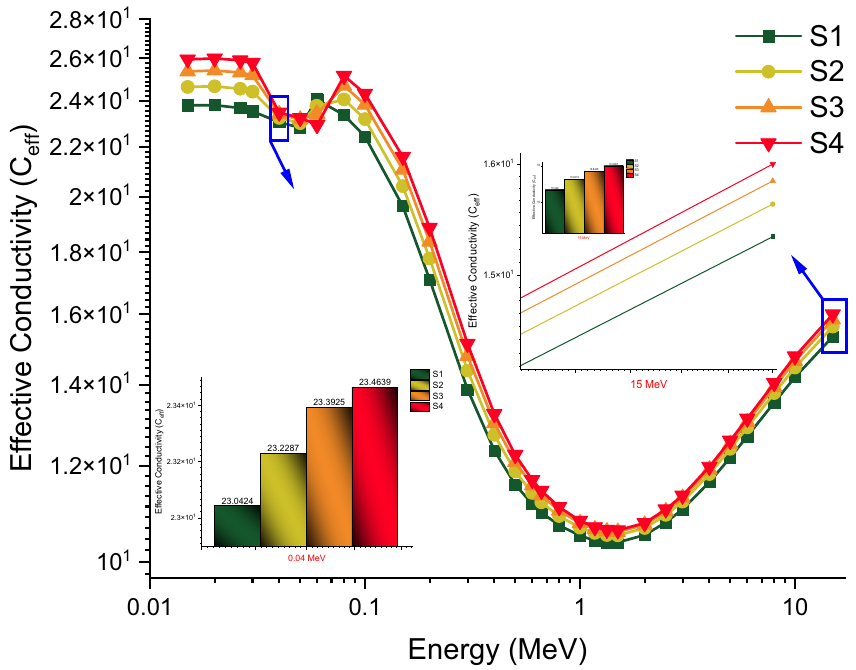
Figure 9: Variation in e ff ective conductivity ( C e ff ) with photon energy ( MeV ) for all S1 – S4 glasses.